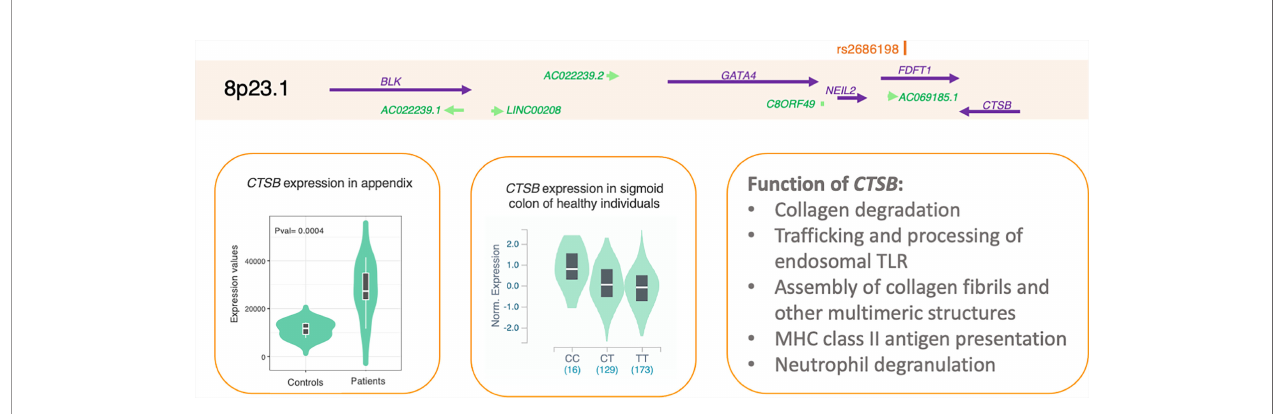
FIGURE 3 | Locus on chromosome 8p32.1. The strongest association in this locus corresponds to SNP rs2686198 with a p-value of 8.48 × 10 − 7 in the Pan- UKBB cohort. There are multiple genes in the locus, but only cathepsin B (CTSB) is signi fi cantly overexpressed in the appendix of patients compared to individuals who were undergoing intra-abdominal surgery for a non-in fl ammatory condition, as depicted in the left panel. The risk allele of rs2686198*C is associated with higher expression of CTSB in sigmoid colon in healthy individuals. The left panel shows the function of CTSB according to Reactome. SNP, single-nucleotide